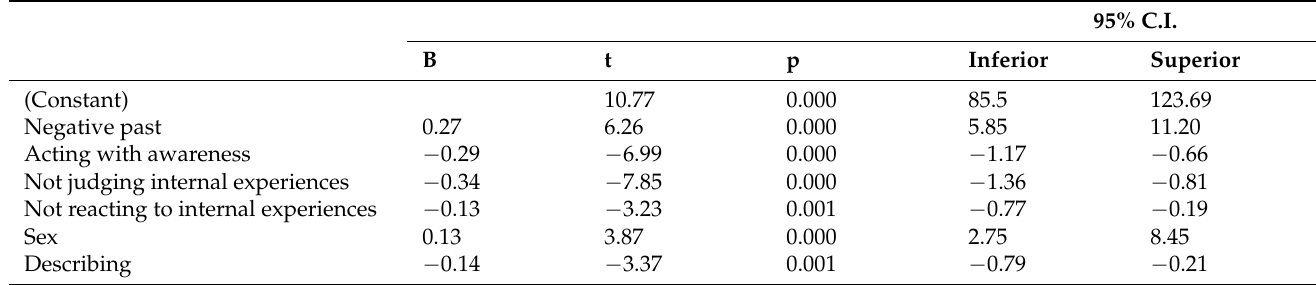
Table 2. Hierarchical Multiple Regression Analysis predicting difficulties in emotional regulation, taking together both time perspective variables and dispositional mindfulness variables (N = 320).